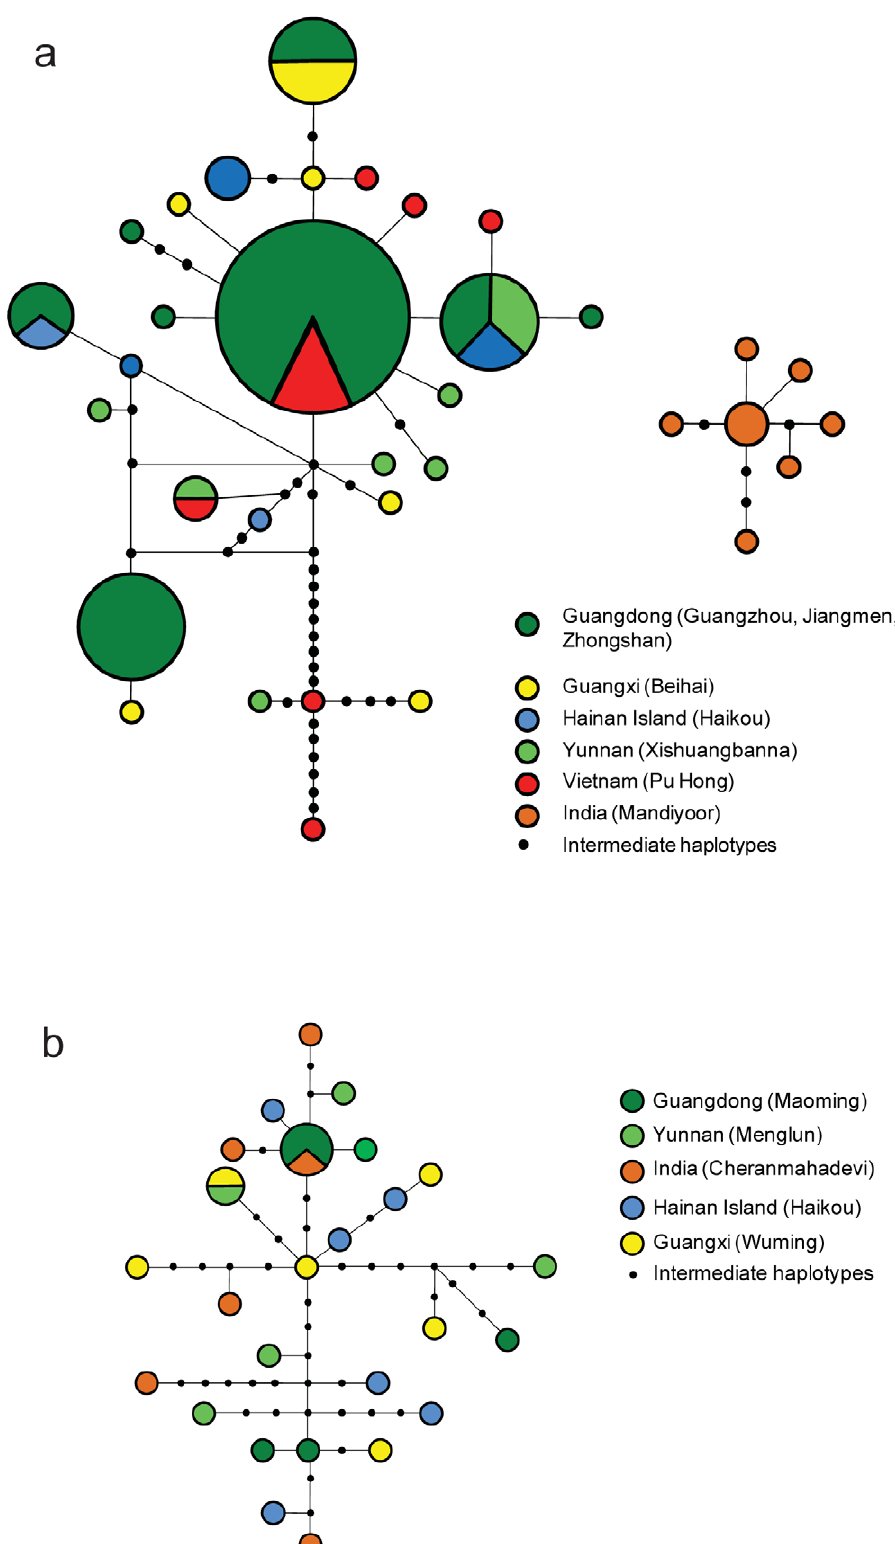
Figure 3. Parsimony haplotype networks for Cynopterussphinx and Rousettusleschenaulti. Parsimony haplotype networks for a) Cynopterus sphinx and b) Rousettus leschenaulti . Haplotypes are colour coded based on sampling locality, as follows: Guangdong = dark green, Yunnan = light green, Hainan = blue, Guangxi = yellow, Vietnam = red, India = pink. Circles are sized in proportion to the number of individuals with that haplotype.